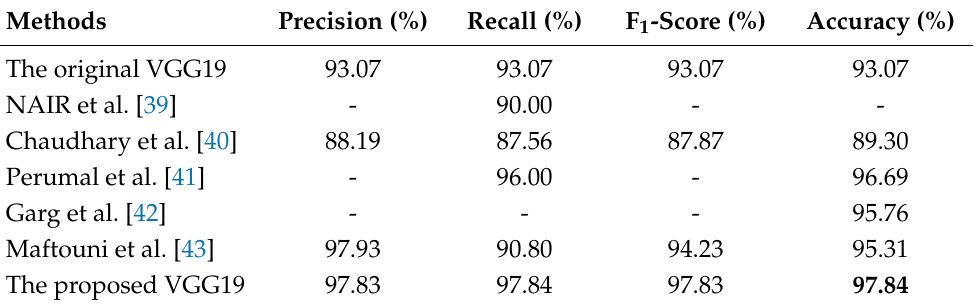
Table 5. Comparison of the proposed and state-of-the-art methods on the medium-sized dataset.